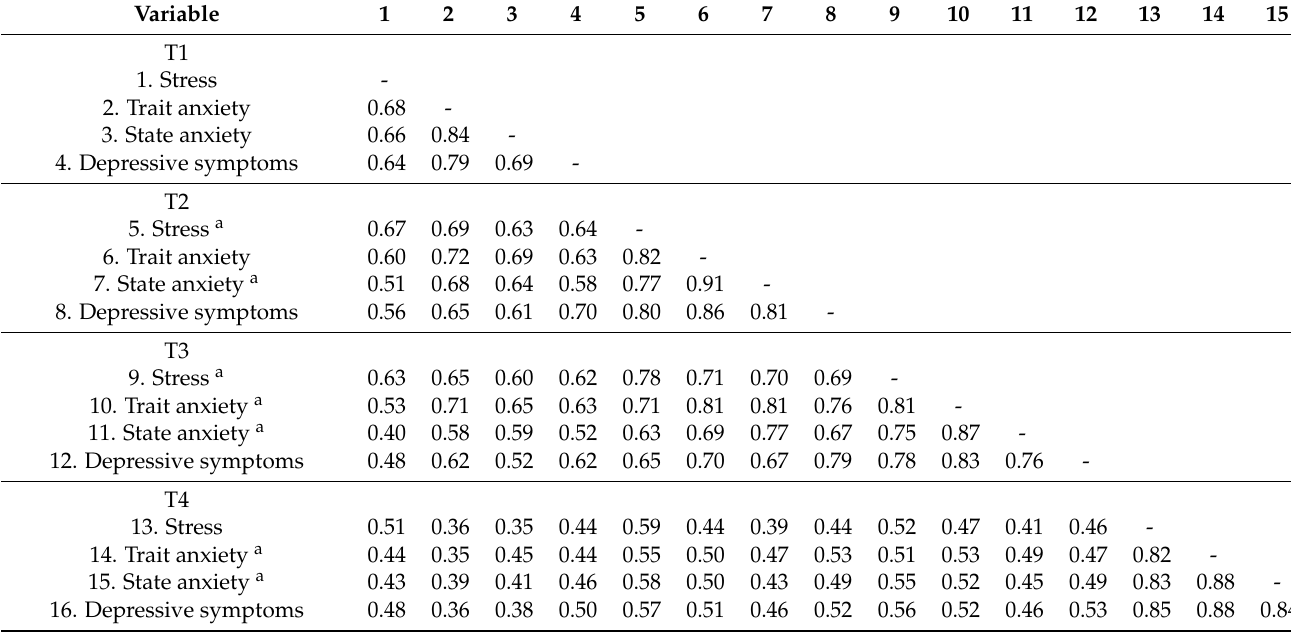
Table 4. Correlations between measured variables.